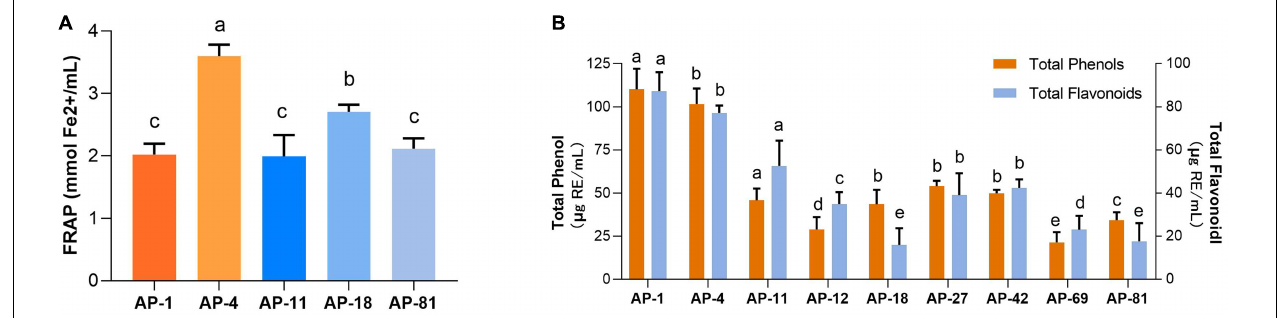
FIGURE 5 | The content of FRAP, total phenols, and total flavonoids of EXEs. (A) FRAP of EXEs. (B) The content of total phenols and total flavonoids of EXEs.